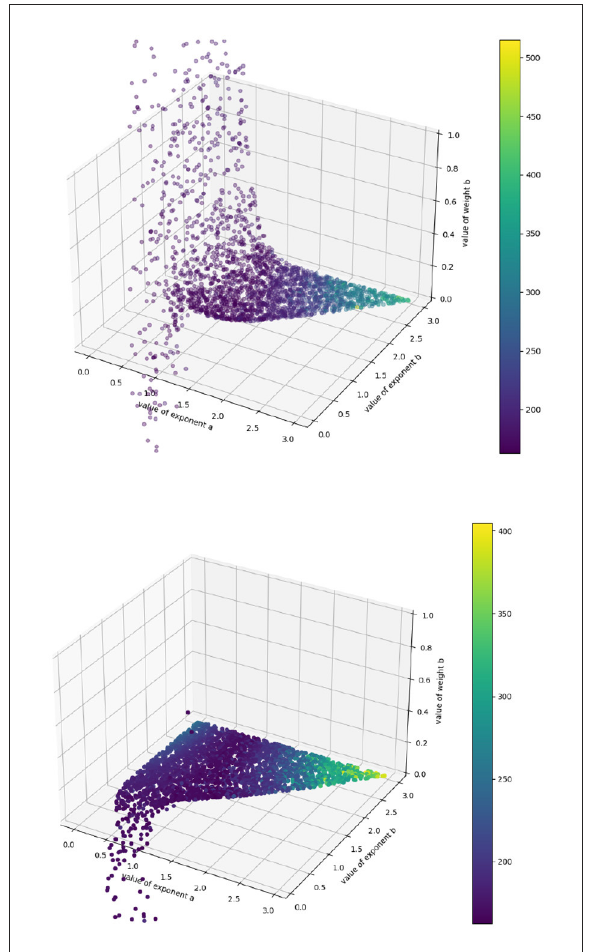
FIGURE3 Fitted p (above) and q (below) values for each exponent-pair value. The colorbar corresponds to SSE—purple datapoints have lower error, yellow ones higher. The varying limits come from the fact that, to generate each plot, we randomly choose 2,500 points out of 45,000 to display.